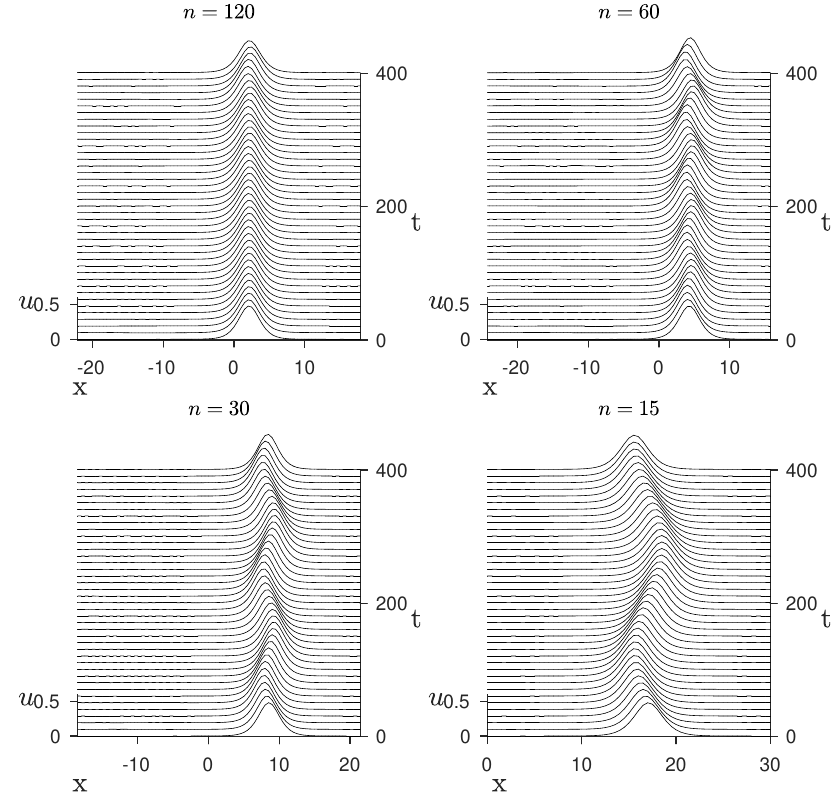
Figure 4. Solitary wave solutions over the periodic forcing. Parameters: ∆ = − 2 a , x 0 = − π /2 q , A = −